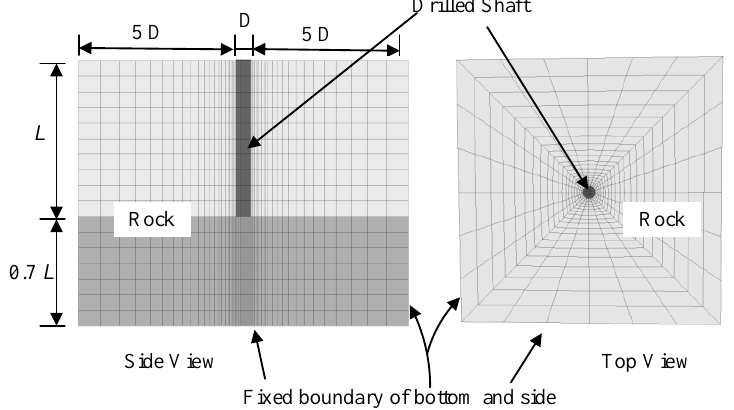
Figure 12. Element meshes of a drilled shaft–rock system.